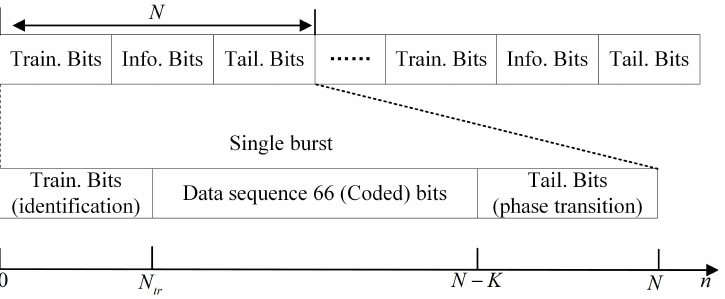
Figure 2. Block diagram of the transmitted CPM burst signal. Labels Train. and Tail. refer to the training and transition symbols,